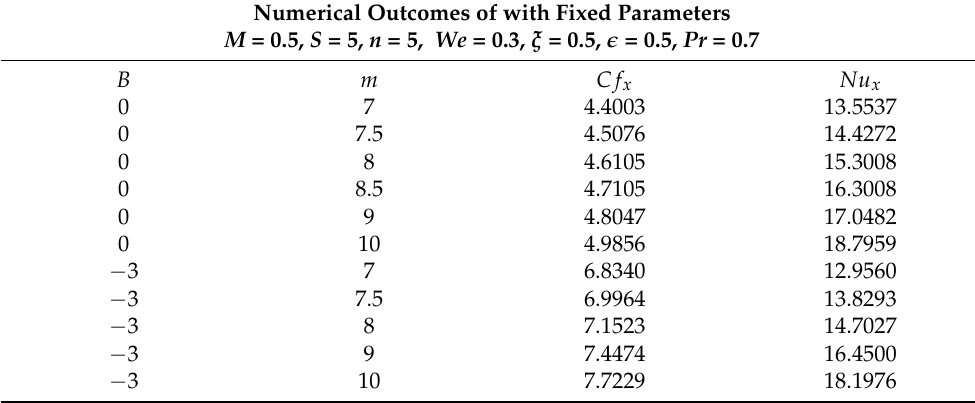
Table 3. The numeric results of the shear stress and Nusselt number under the influence of stretching ratio and non-linear parameter. Numerical Outcomes of with Fixed